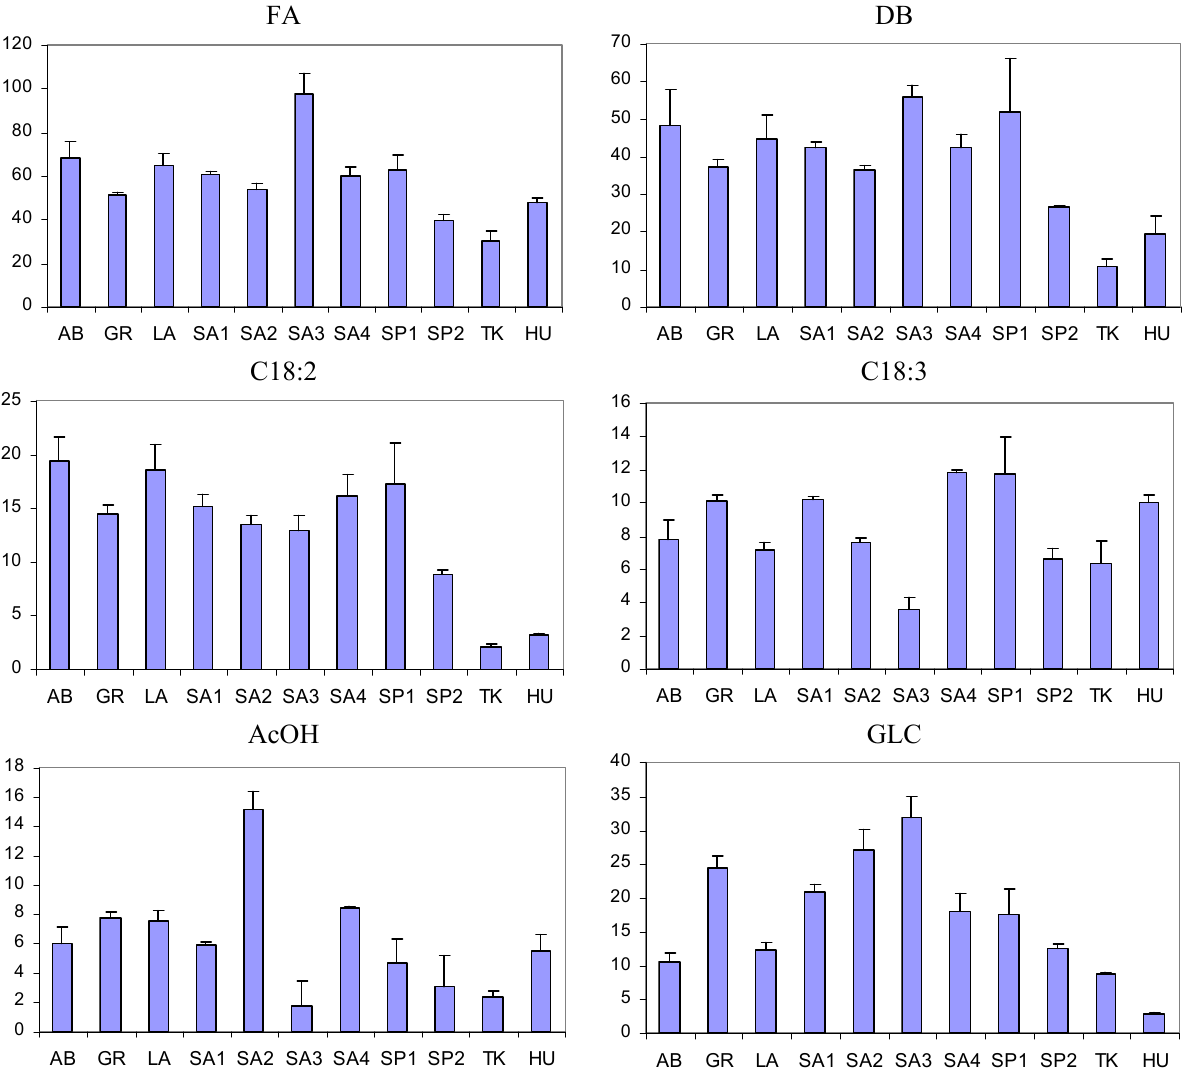
Figure 5. Histograms relative to the intensity of selected metabolites (arbitrary units); see Tables 1 and 2 for abbreviations. Mean values and standard deviations for each metabolite are